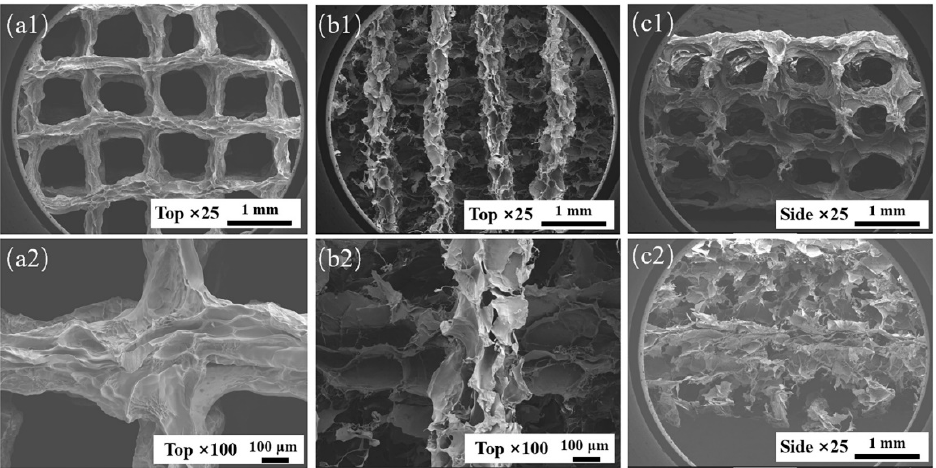
Figure 5. SEM images of AP1000 and EP1000, ( a1 , a2 ) top views of AP1000; ( b1 , b2 ) top views of EP1000; ( c1 ) side views of AP1000; ( c2 ) side views of EP1000.